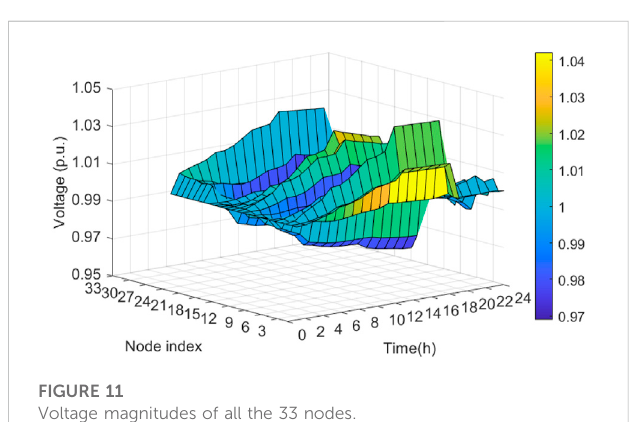
FIGURE 11 Voltage magnitudes of all the 33